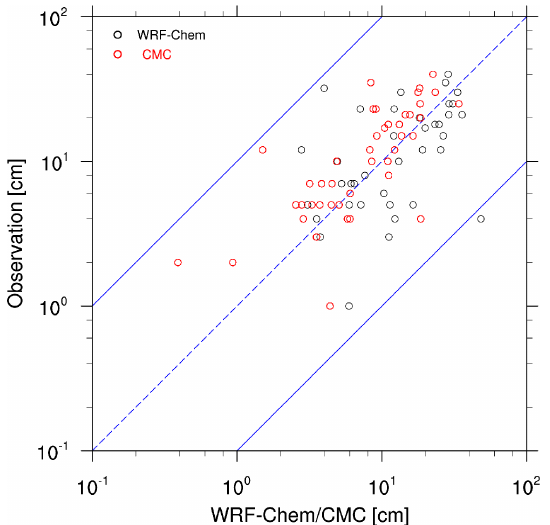
Figure 3. The campaign observations of snow depth (cm) versus the corresponding WRF-Chem simulations (black dots) and CMC reanalysis (red dots).